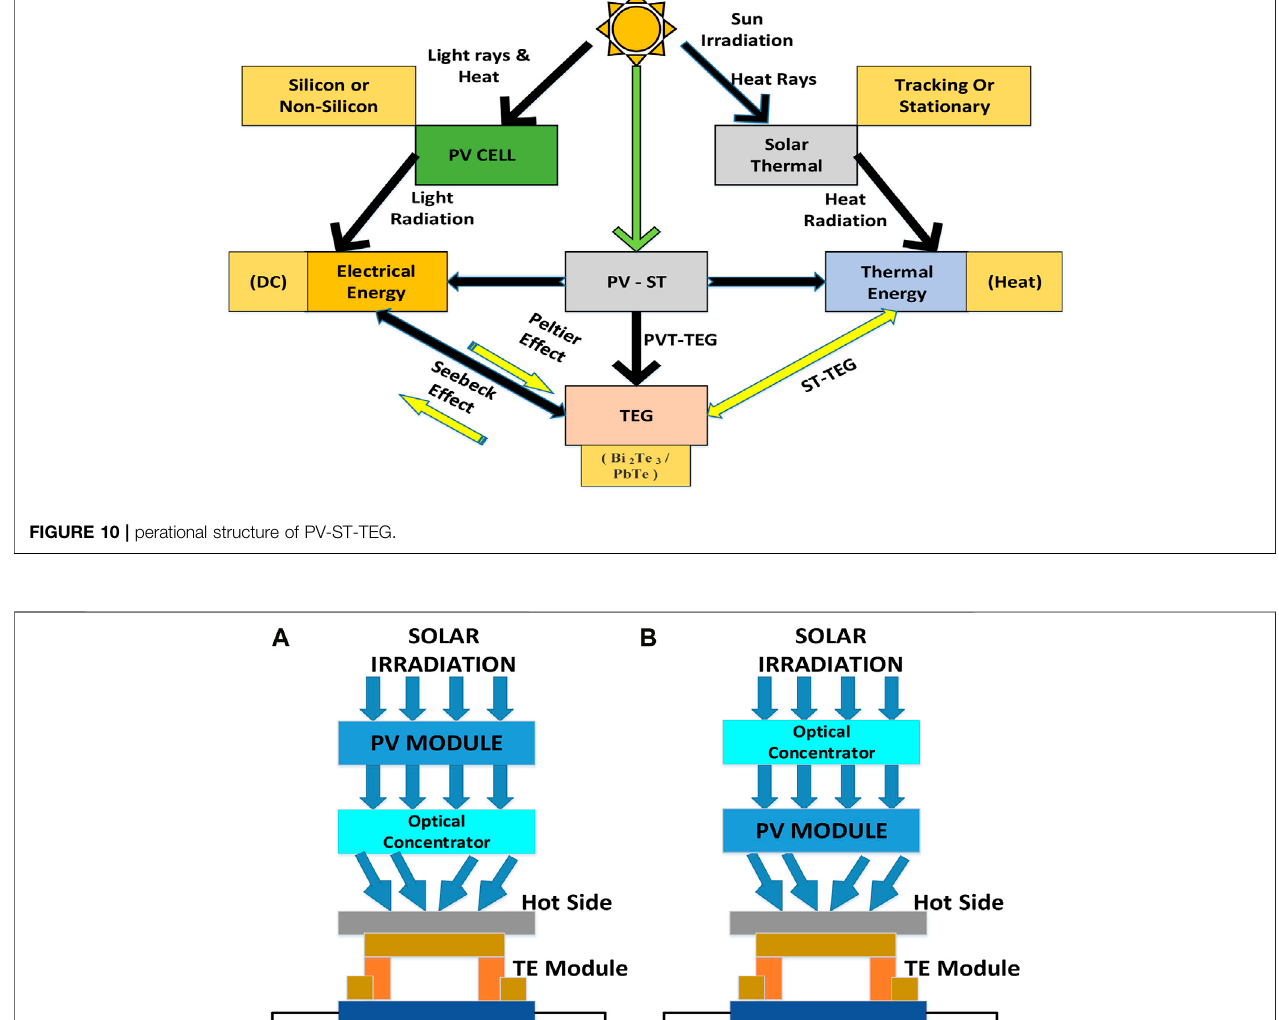
Frontiers in Energy Research |